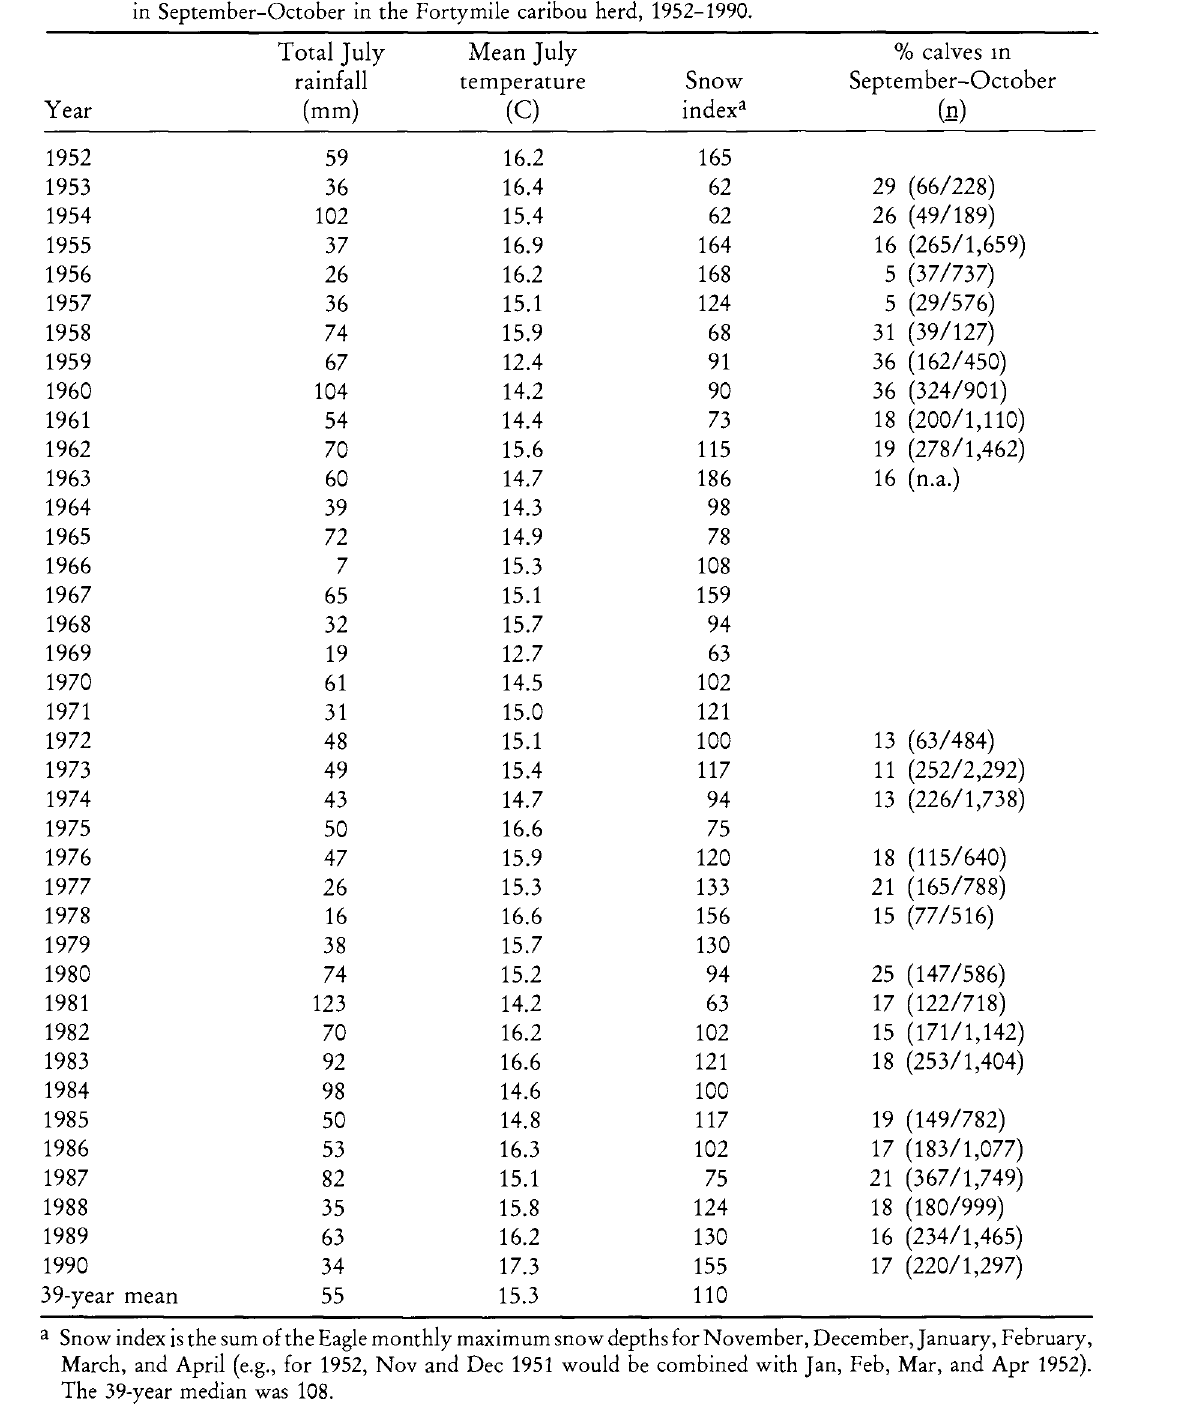
Table 5. Total July rainfall, mean July temperature, snow index (after Van Ballenberghe, 1985), and percent calves in September-October in the Fortymile caribou herd,